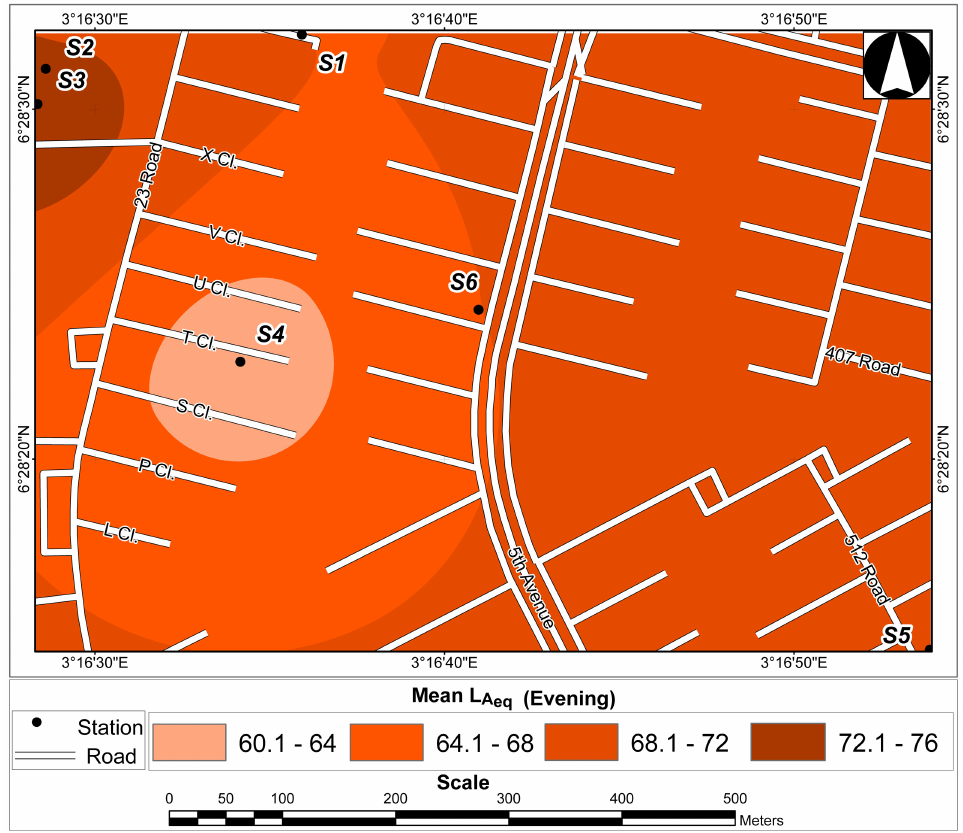
Figure 7: Mean L Aeq for the evening period derived by kriging interpolation Table 5: Analyis of variance Sum of squares df Mean square F